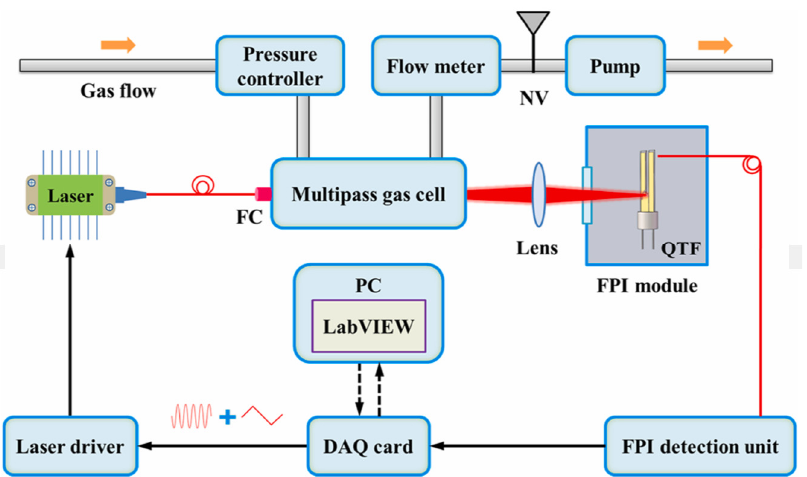
Figure 15. Experimental setup of the all-optical LITES sensor system based on the FPI technique. FC: fiber-coupled collimator; NV: needle valve; PC: personal computer. Reprinted/adapted with permission from Ref. [138]. Copyright 2022, copyright Elsevier.